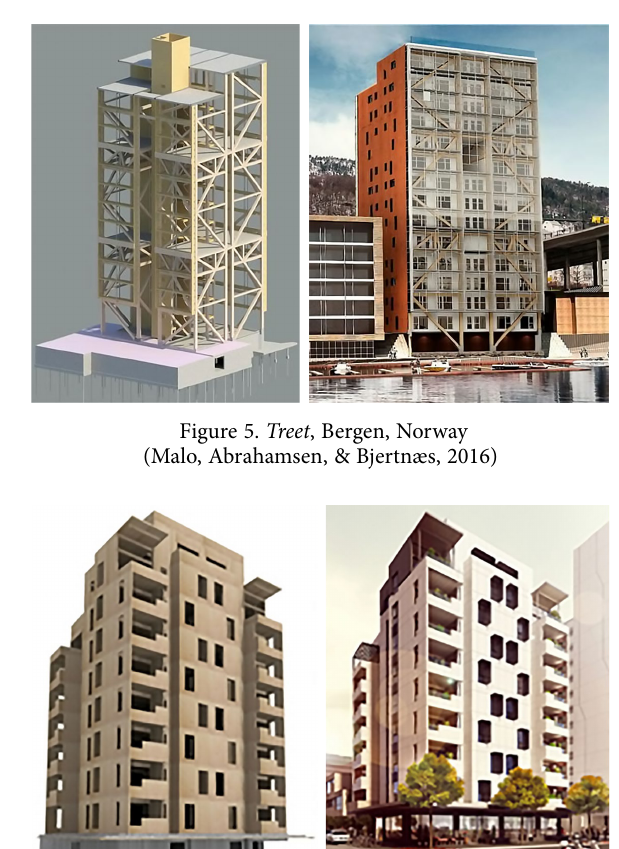
Figure 4. Brock Commons Tallwood House , Vancouver, Canada (Wood Skyscrapers, 2016; Archinect, 2016)